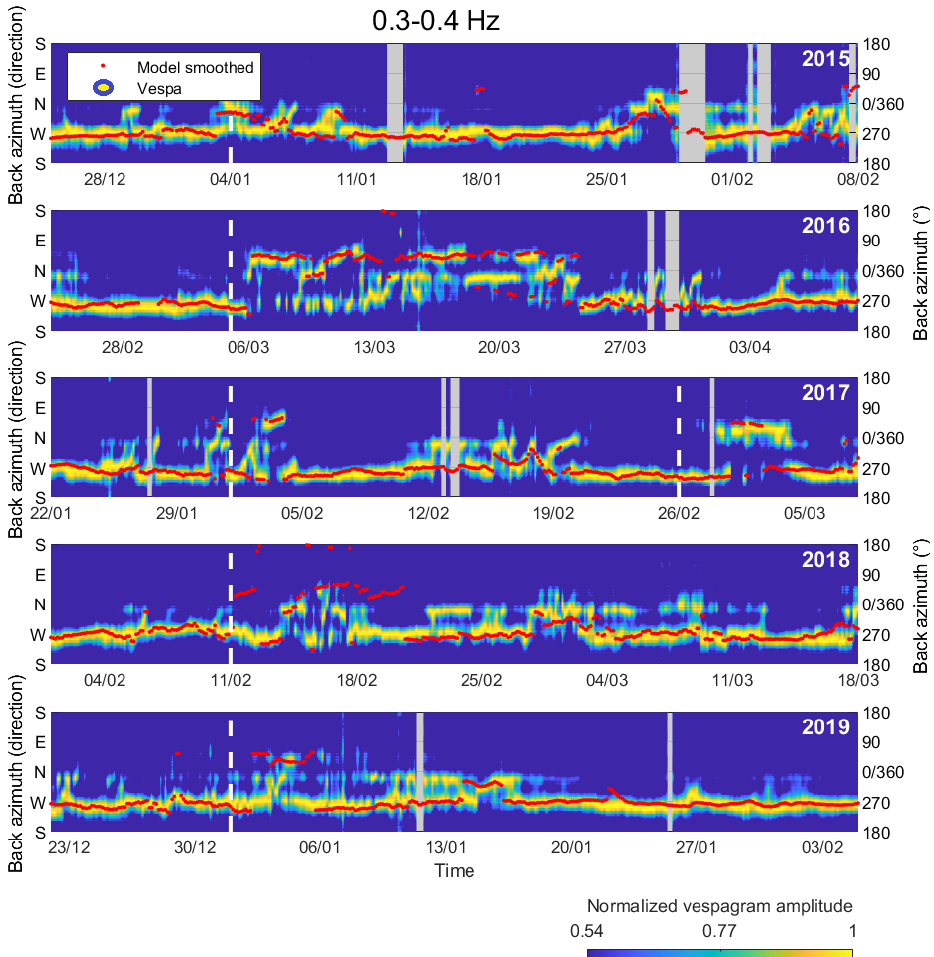
Figure 6. Comparison between microbarom azimuthal distributions at IS37 (vespagrams) normalized per time step and the back azimuths of the dominant signals as predicted by the model (red dots). The results are shown around SSWs 2015–2019 for the 0.3–0.4Hz band. White vertical dashed lines indicate onset days when SSWs (minor or major) criteria were met. Gray fields indicate periods where infrasound data are disregarded due to noise and an indistinct directional